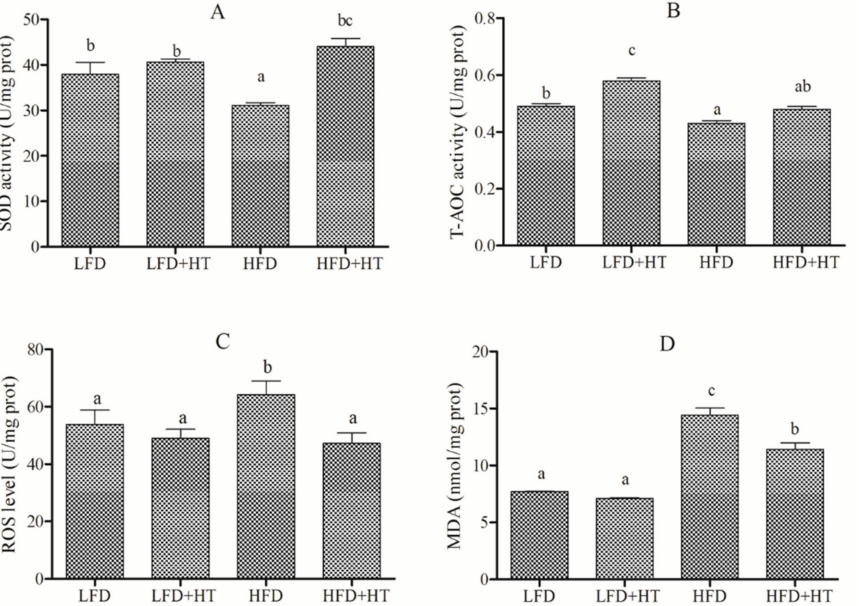
Figure 2. ( A ) Activity of superoxide dismutase (SOD); ( B ) total antioxidant capacity (T-AOC); ( C ) concen- trations of reactive oxygen species (ROS); ( D ) malondialdehyde (MDA) in liver of blunt snout bream fed with experimental diets. Bars with different letters are significantly different ( p <